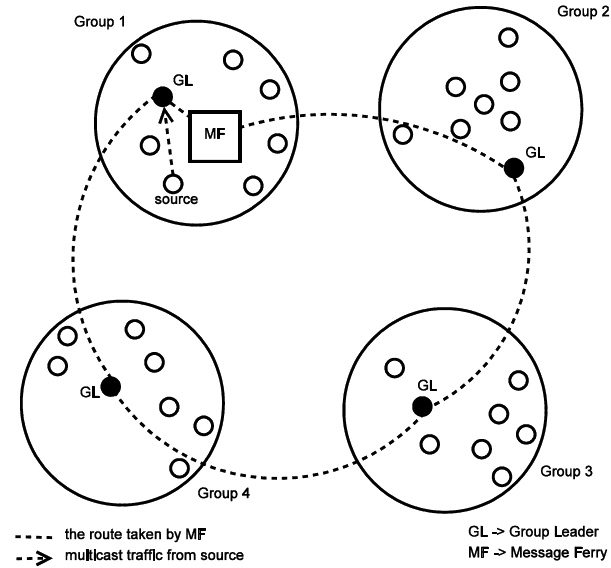
Figure 12 . Ferry-based interdomain multicast routing (FBIMR) scheme [67]. Figure 12. Ferry-based interdomain multicast routing (FBIMR) scheme